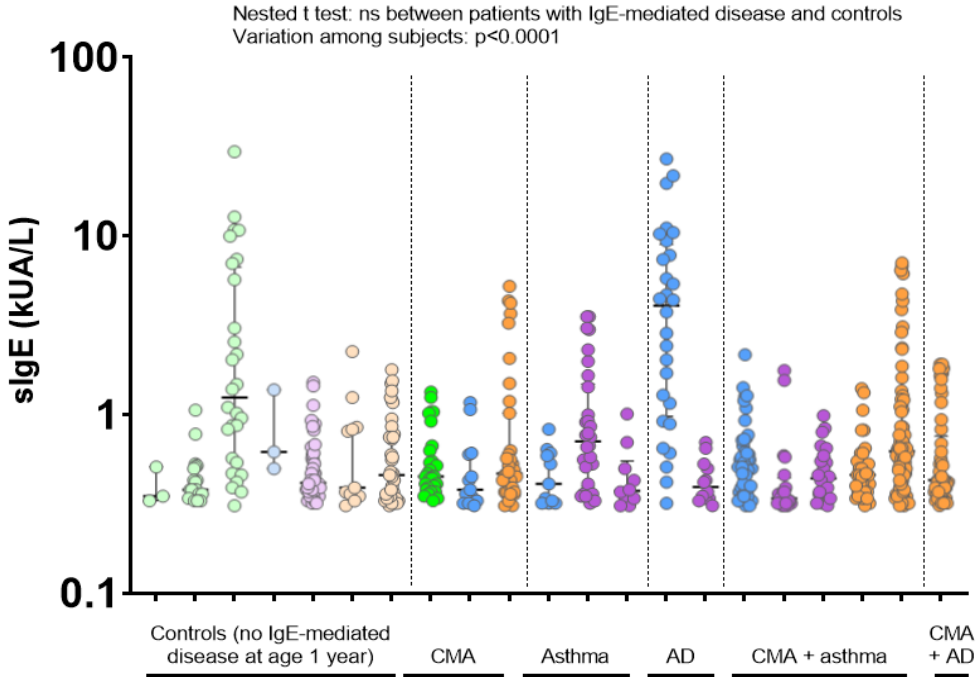
Figure 3. Levels of fecal sIgE reactivity in preterm infants according to the presence or absence of IgE-mediated disease at the age of 1 year. Values of sIgE greater than 0.30 kUA/L are represented. The colors denote the age at which the samples were taken (green: meconial; blue: 2–5 weeks; purple: 6–8 weeks; orange: 9–14 weeks), with the light shades denoting the control subjects and the dark shades denoting the patients who developed IgE-mediated diseases by the age of 1. AD, atopic dermatitis; CMA, cow’s milk allergy; ns, not significant.